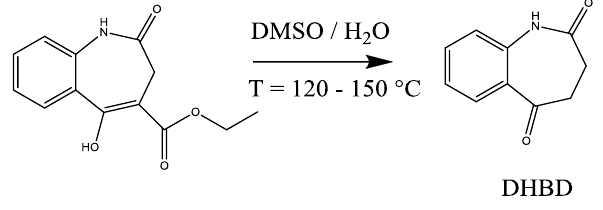
Figure 4. Synthesis of 3,4-dihydro-1 H -1-benzazepine-2,5-dione